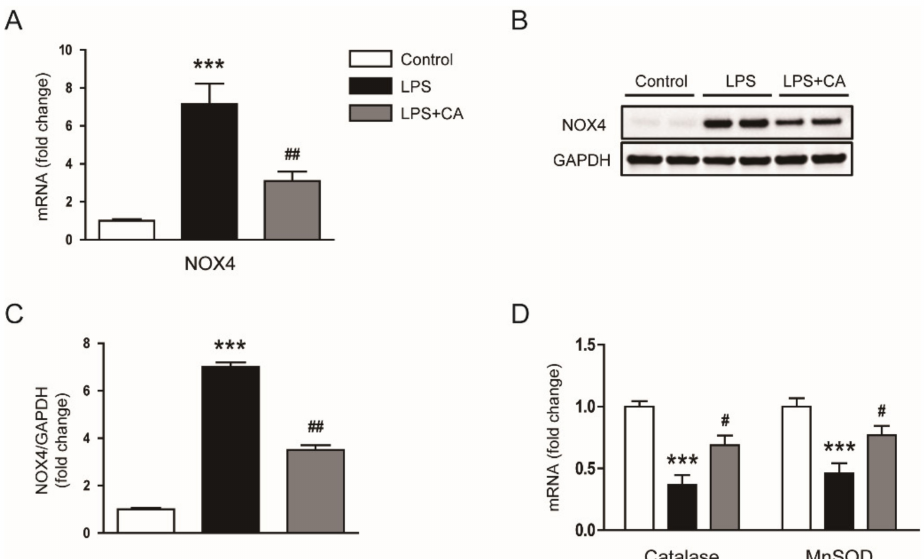
Figure 7. Effect of carnosic acid on the expression of NOX4, catalase, and MnSOD. ( A ) The mRNA expression of NOX4 in kidney tissues. ( B ) Western blotting of NOX4 in kidney tissues. ( C ) Quantifi- cation of Western blot data for NOX4. ( D ) The mRNA expression of catalase and MnSOD in kidney tissues. *** p < 0.001 versus control. # p < 0.05 and ## p < 0.01 versus LPS.